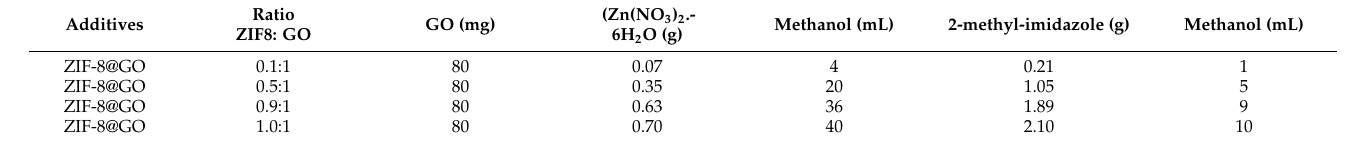
Table 1. Composition of different concentration for the construction of ZIF-8@GO composites.